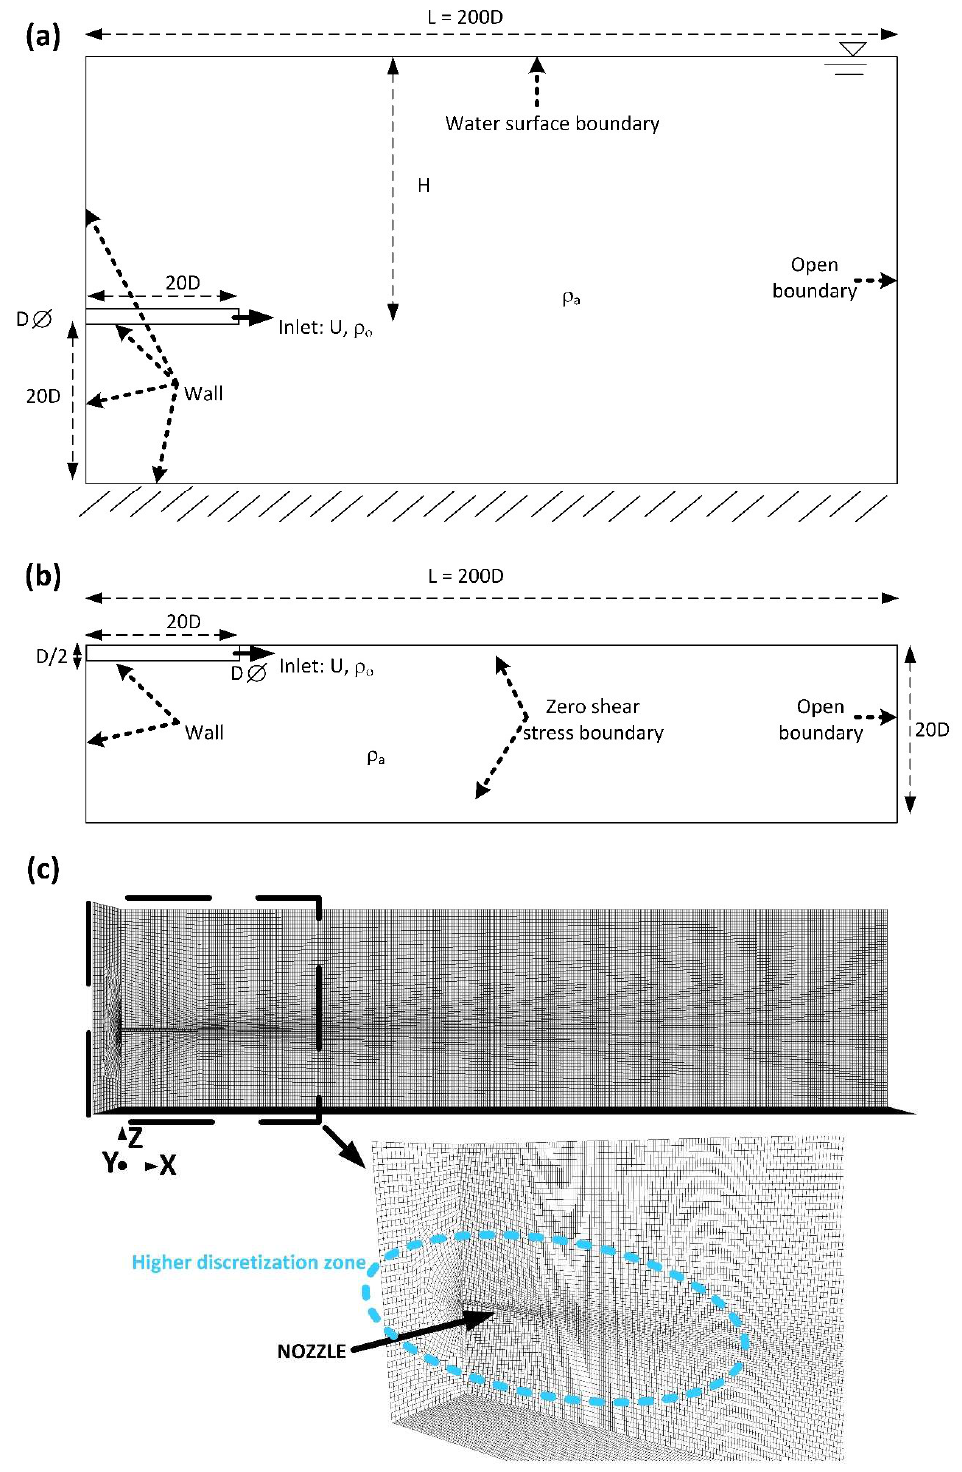
Figure 2. Mesh grid scheme for the simulation of a jet in a stagnant medium interacting with the water-free surface by means of the computational fluid dynamics (CFD) model: ( a ) profile view, ( b ) plan view, and ( c ) example of CFD mesh grid.